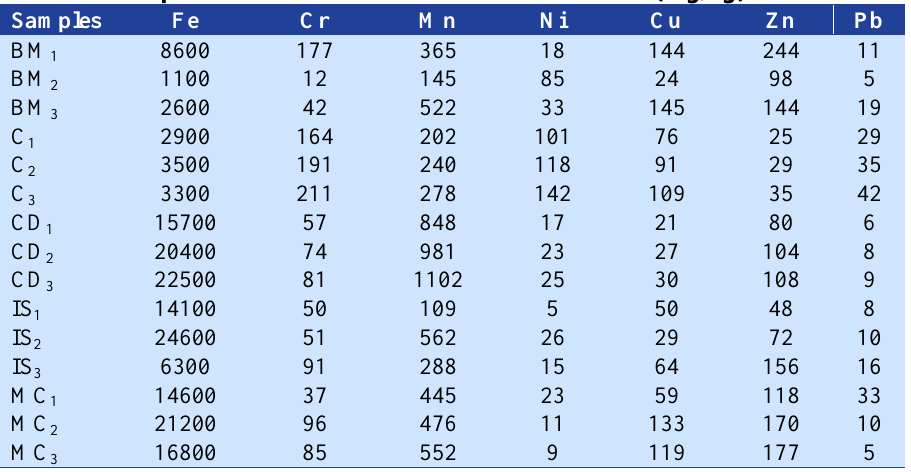
Table 2. Composition of metals in indoor ash residues (mg/kg)